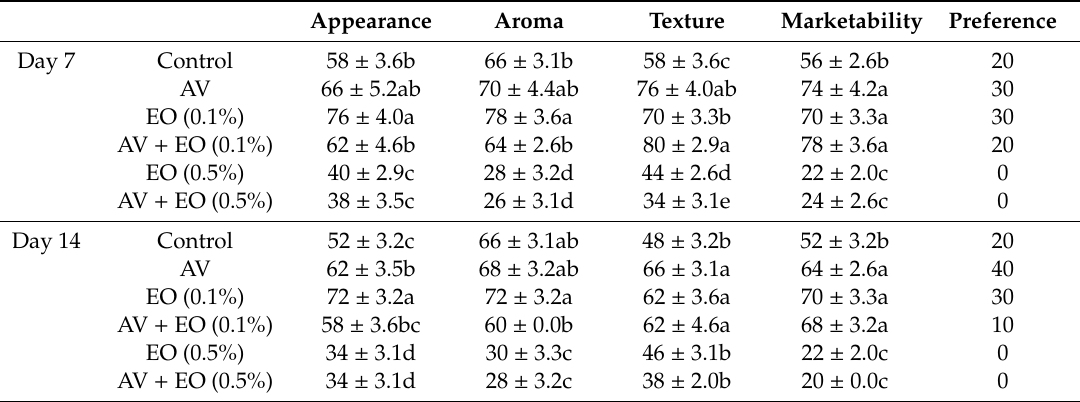
Table 3. Quantitative analysis of the impacts of Aloe vera (AV at 10%) coating and / or sage essential oil (EO at 0.1% and 0.5%) on sensory attributes of tomato fruit after 7 and 14 days of storage. Fruit were maintained throughout at 11 ◦ C and 90% RH. Values (%) represent mean ( ± SE) of assessments made by 10 panelists per